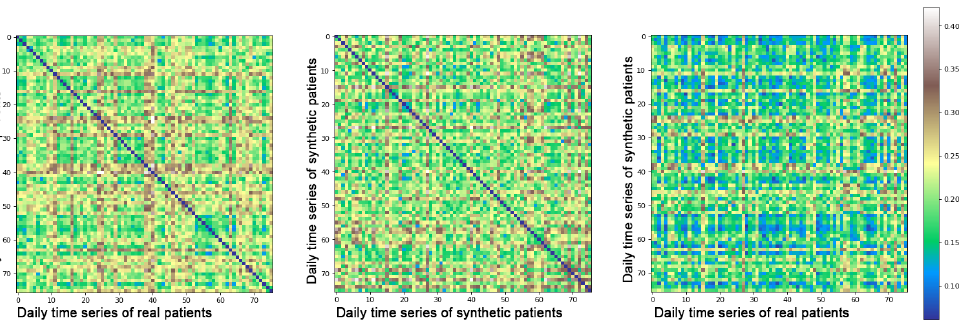
Figure 4. Heat maps representing distances of real and synthetic samples of Barcelona